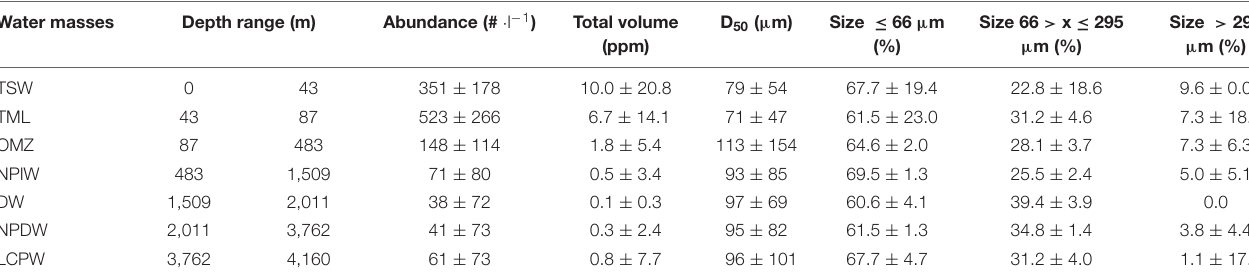
TABLE 3 | Station 2.2 particle-related parameters summary from each water